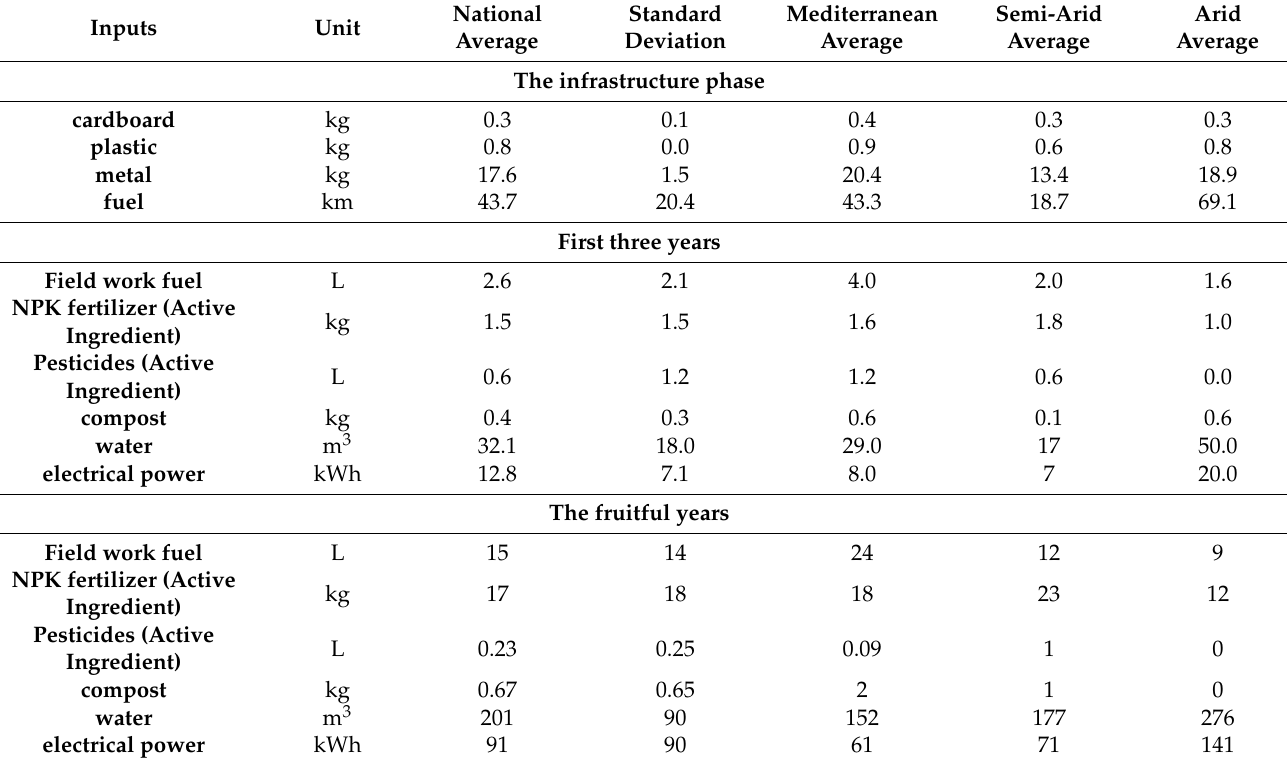
Table 1. Average inputs per ton of grapes of the vineyard in the research